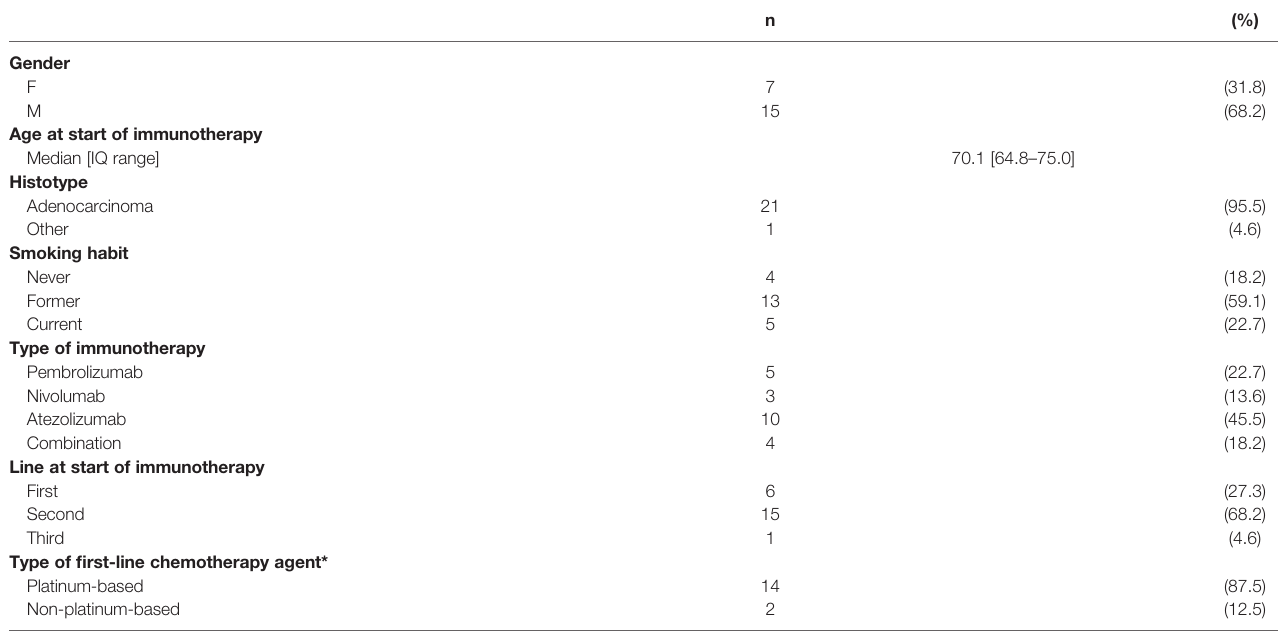
TABLE 1 | Patients ’ baseline characteristics (n = 22).